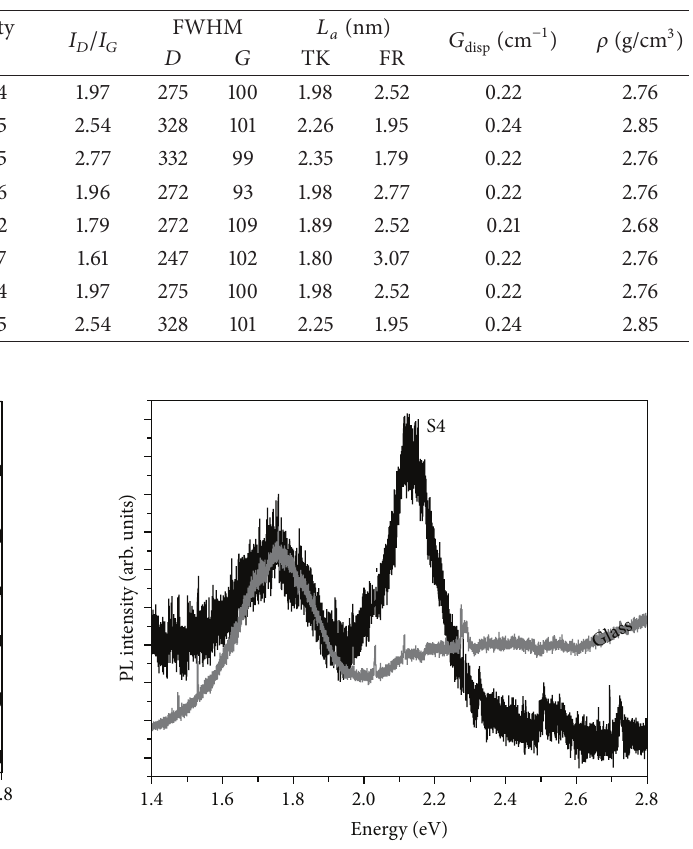
Figure2:ComparativePLspectraofthesubstrate(glass)asreceived and after deposition of the CN 𝑥 film